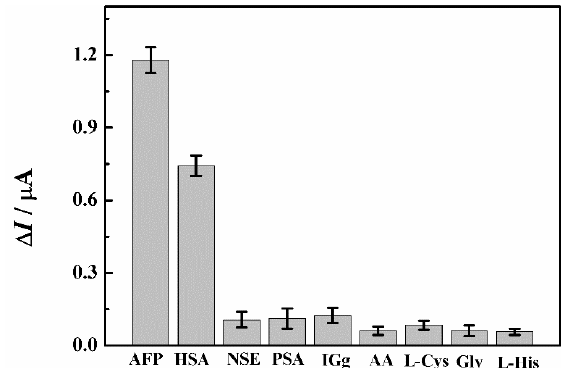
Figure 9. Current response of the imprinted sensor towards potential interferents.